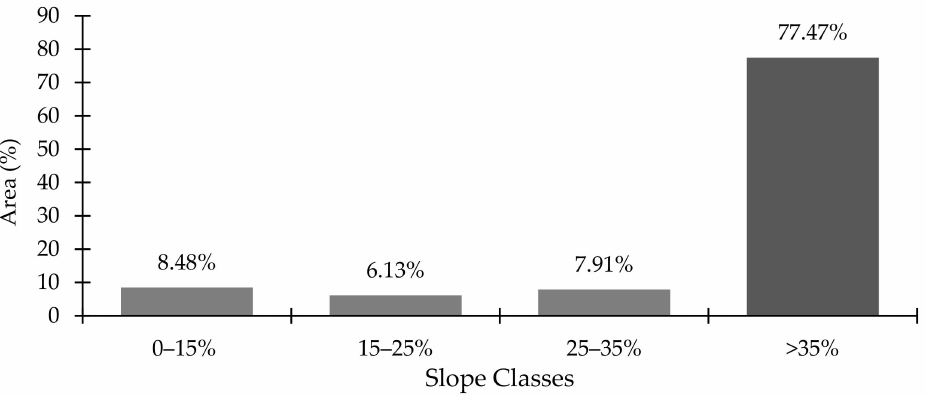
Figure 3. Slope classes and their area coverage (%) across the study